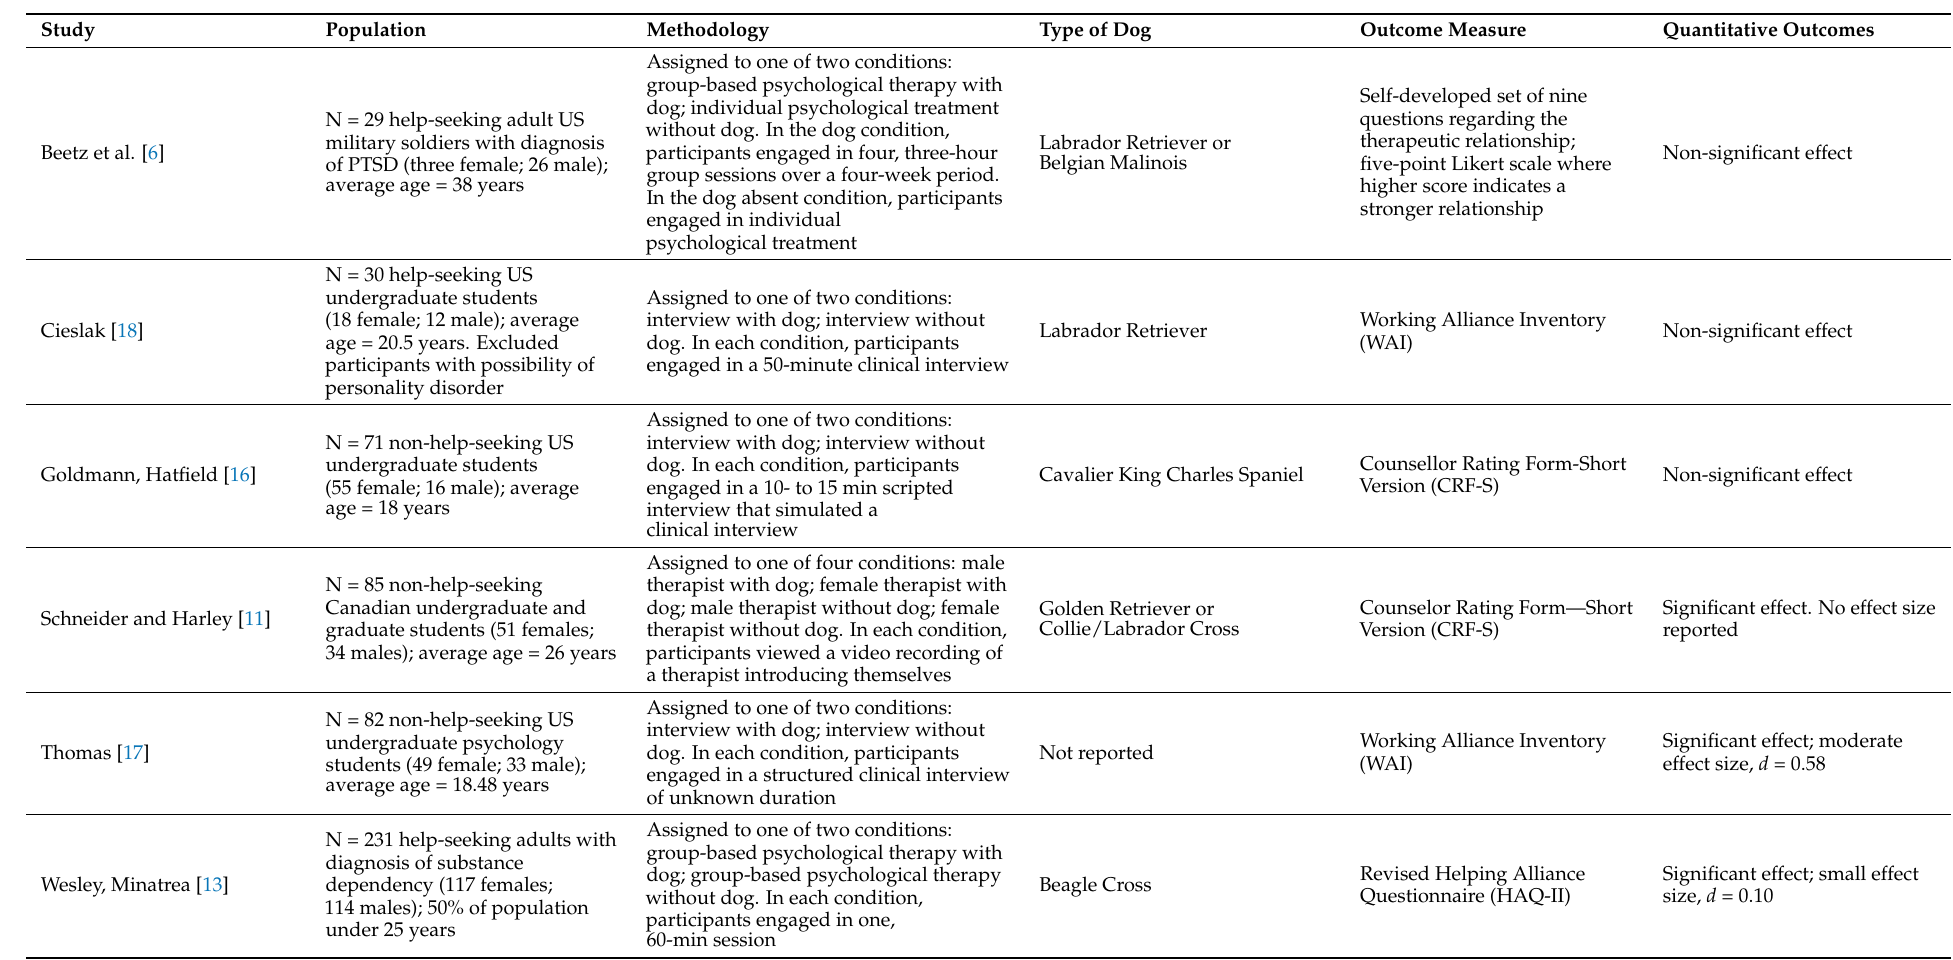
Table 1. Summary of Data Extraction for Included